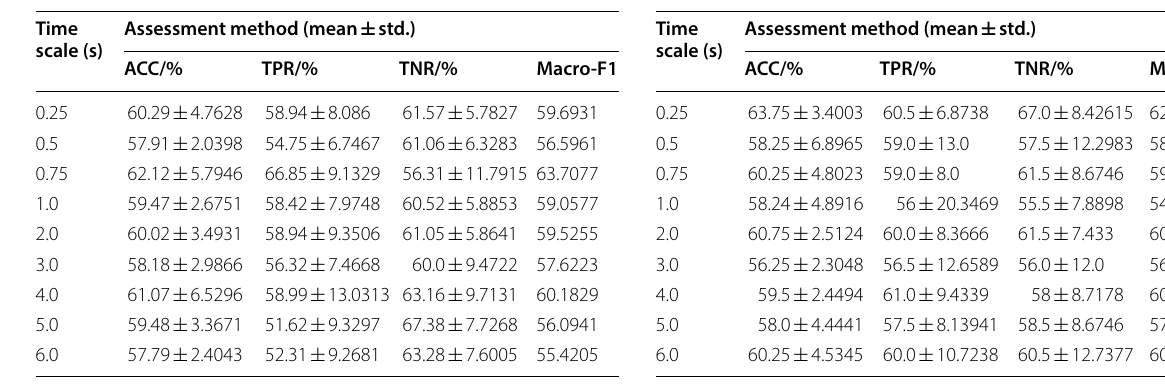
Table 3 The classification results of RT‑ERM with different time scales for β rhythm under the dimension of emotion valence Time Assessment method (mean scale (s)